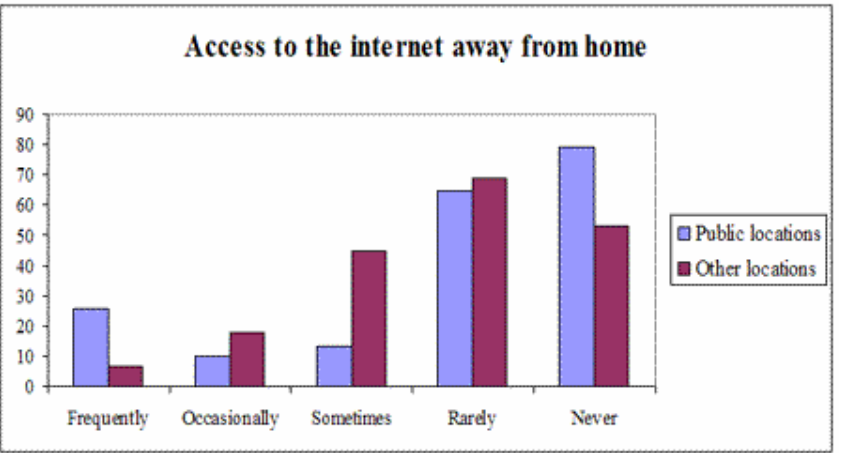
Figure 1. Respondents’ Access to the Internet Outside their